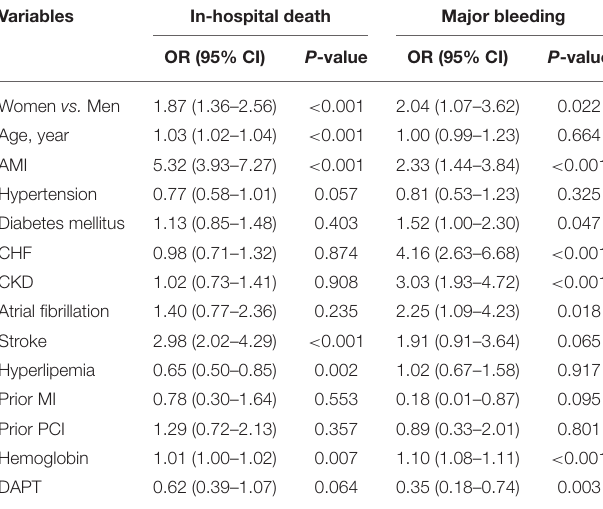
TABLE 3 | Multivariate risk regression model of